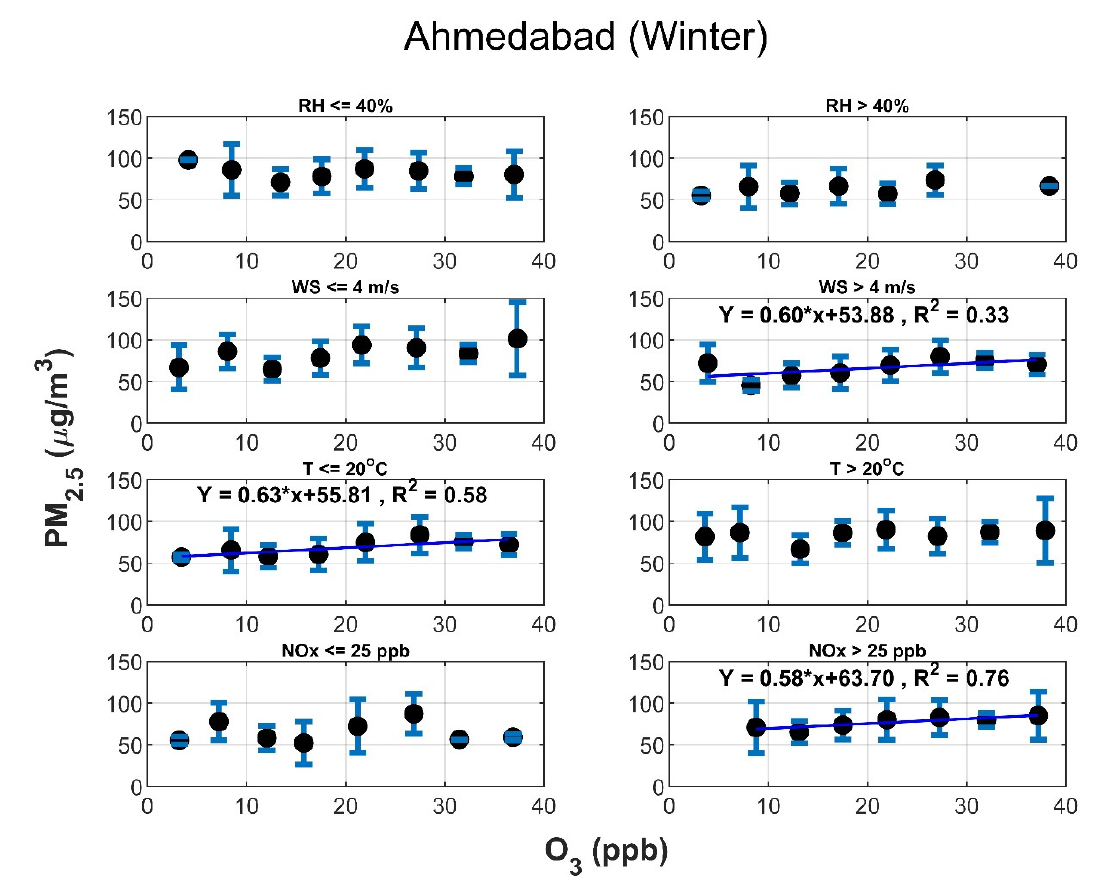
Figure 8. Dependence of PM 2.5 concentrations on O 3 in Ahmedabad during the winter season for different meteorological parameters.